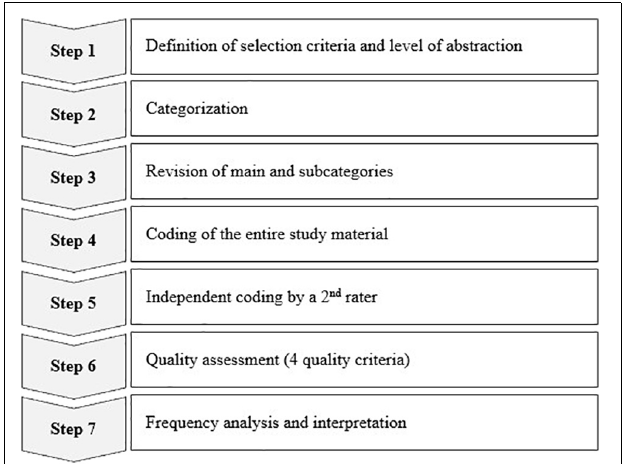
FIGURE 1 | Schematic overview of the qualitative content analysis